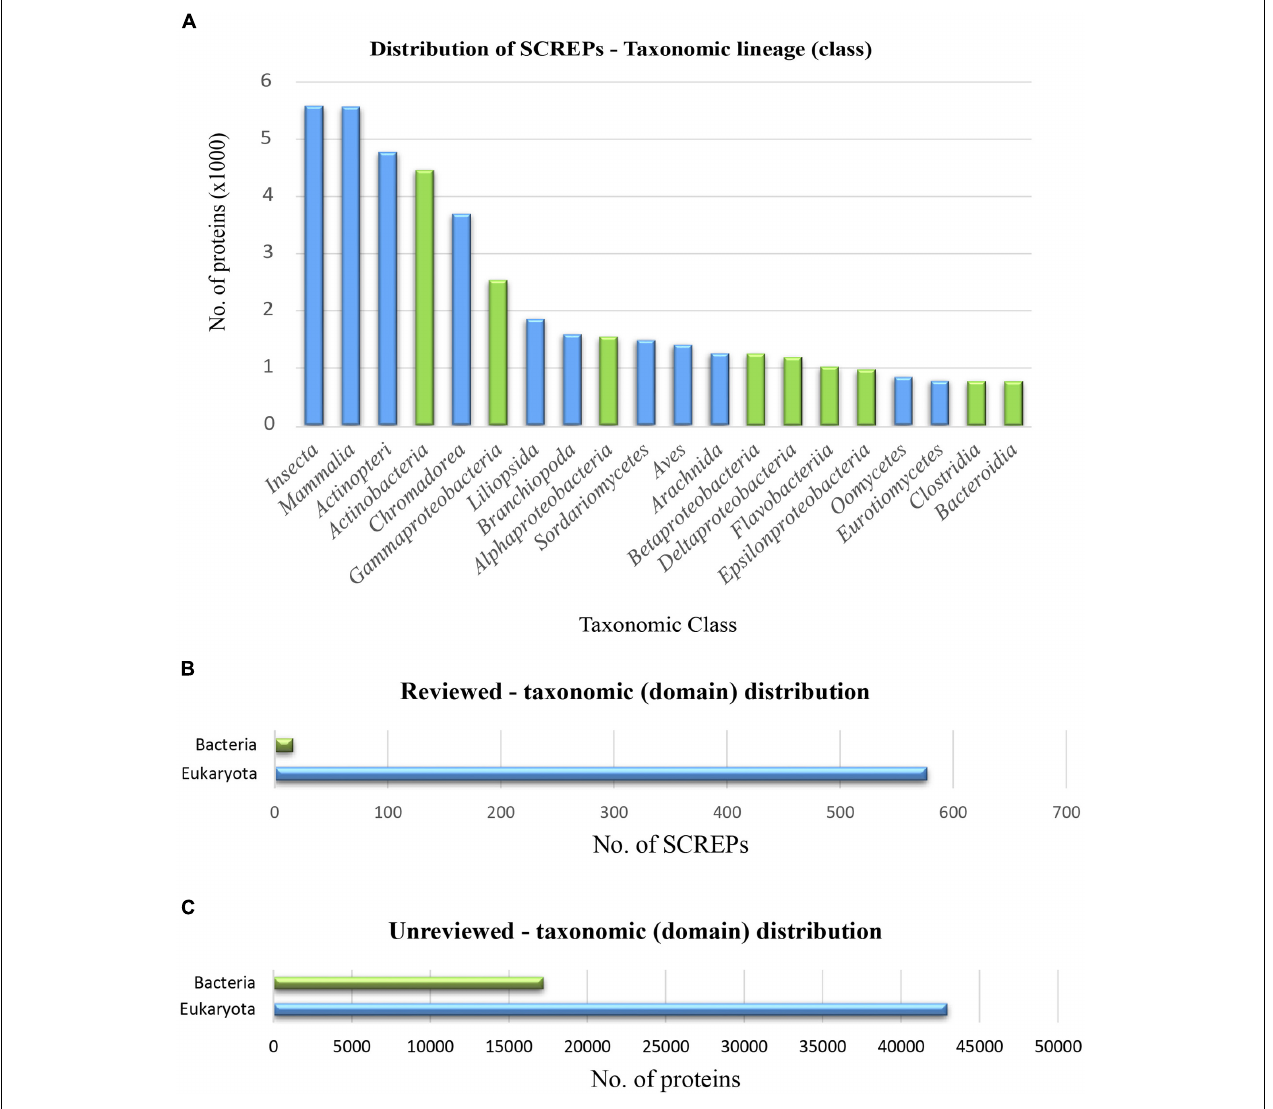
FIGURE 5 | Taxonomic distribution of SCREPs. (A) Distribution of the 20 highest occurring taxonomic classes of SCREPs, blue indicating eukaryotic members and green indicating bacterial. (B) The total frequency of reviewed SCREPs within their respective taxonomic domains. (C) The total frequency of unreviewed SCREPs within their respective taxonomic